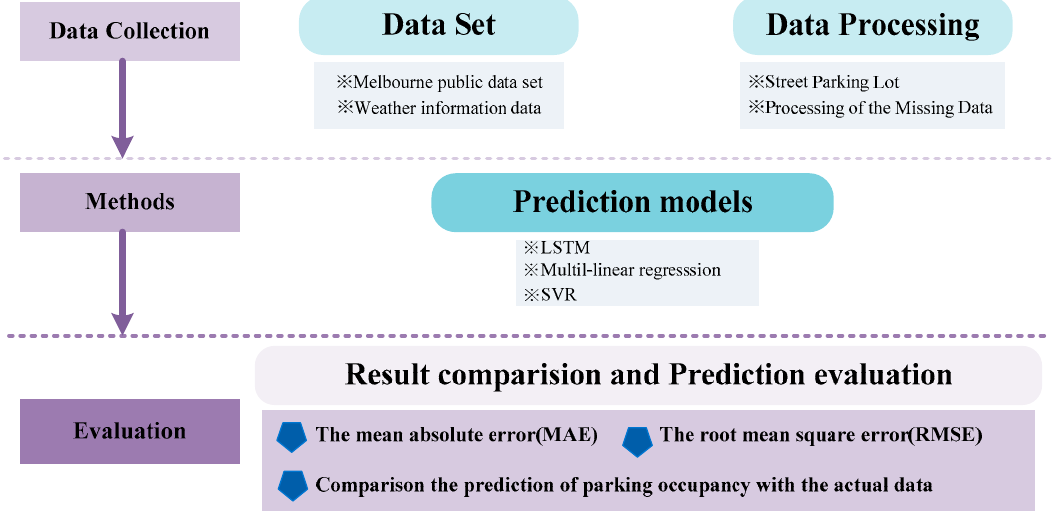
Figure 3. The research framework of short-term parking occupancy prediction.